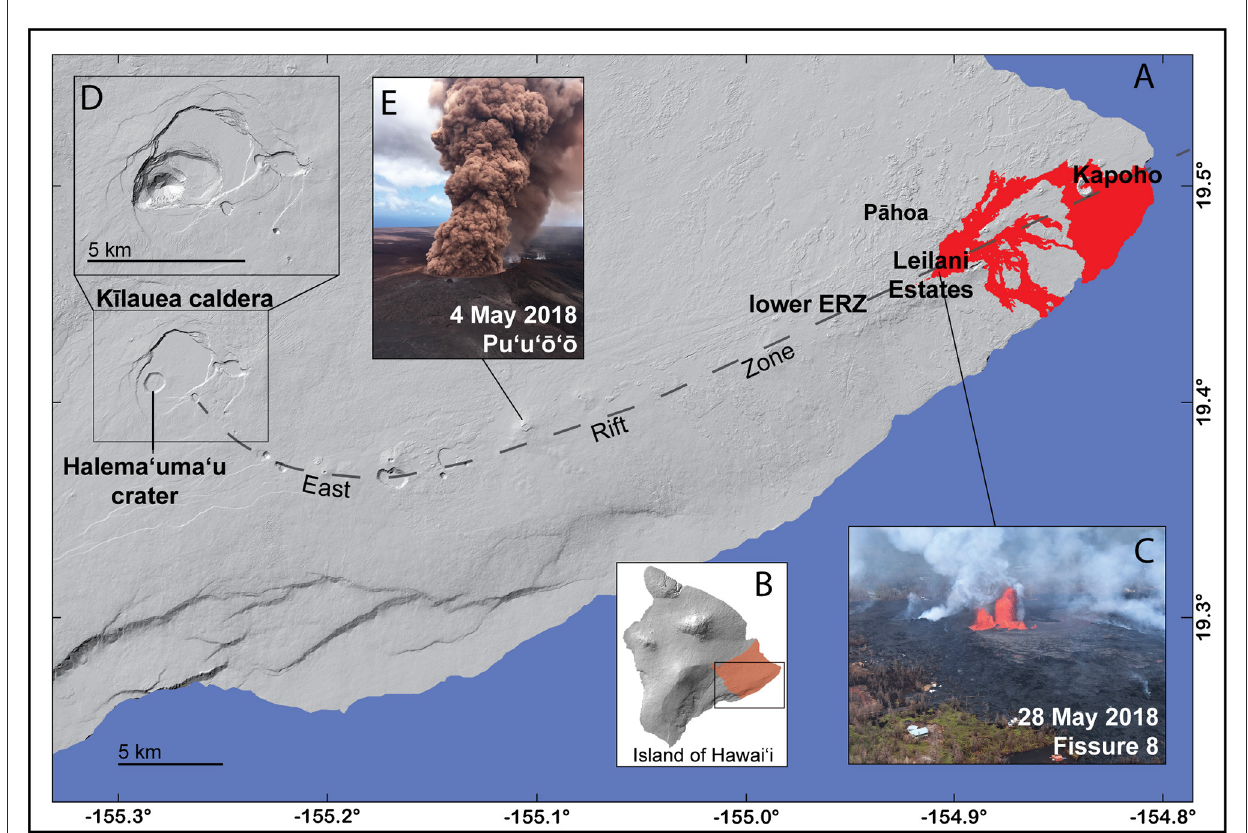
FIGURE1 Digital elevation model of K¯ılauea volcano prior to the 2018 eruption (A) . K¯ılauea, located on the Island of Hawaii (B) , is the state’s most active volcano and was the site of two eruptions in 2018. Lava flows (red area on the right side of A ) erupted through neighborhoods (C) and added new land to the island’s shoreline. Fissure 8 (C) was the primary source of destructive lava flows that originated in Leilani Estates and eventually reached Kapoho. A total of 612 residences were lost a in the Puna district (orange shaded area in B ) during the eruptions. Halema‘uma‘u crater floor within K¯ılauea caldera collapsed by about 500m during the 2018 eruption. The post-caldera-collapse digital elevation model (inset D ) is based on airborne lidar surveys flown in 2019 (Mosbrucker et al., 2020). On May 4, 2018, 12:44 p.m. HST, a column of robust, reddish-brown ash issued from Pu‘u‘o‘o (E) after a magnitude 6.9 earthquake beneath the south flank (Neal et al., 2019). Pu‘u‘o‘o had been the primary eruption center on K¯ılauea for 35 years prior to the changes in 2018, USGS photographs. a https://recovery.hawaiicounty.gov/resources/2018-eruption.